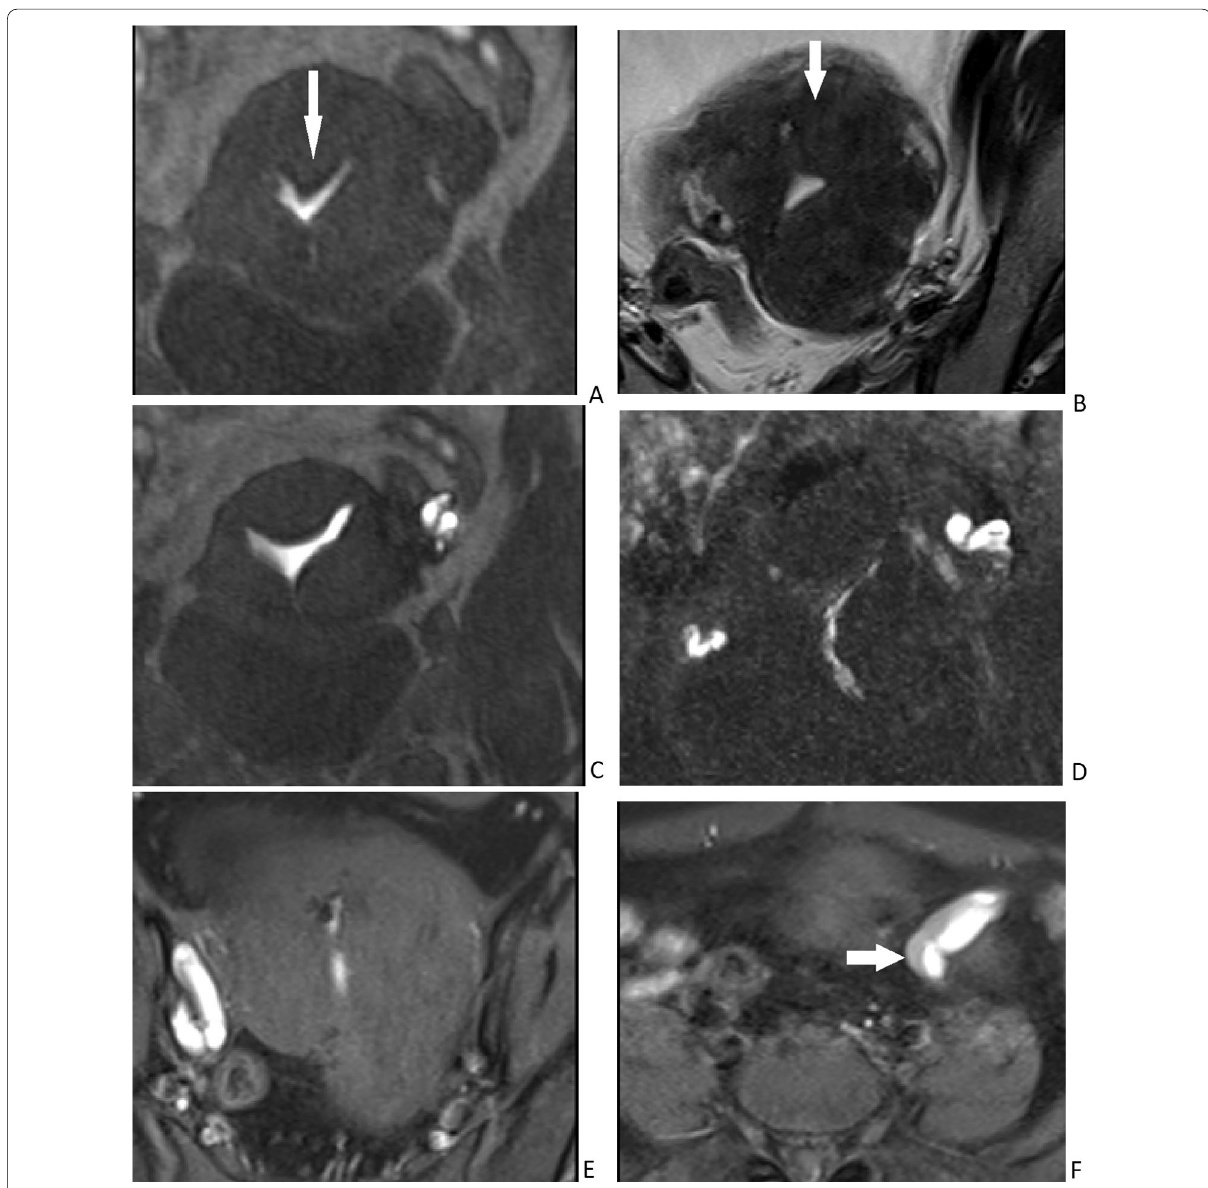
Fig. 5 Thirty-five-year-old female evaluated for primary infertility, A-F subtracted dynamic 3D T1 weighted angiographic (TRICKS) MR HSG image of first injection of dilute gadodiamide showing deformity of endometrial cavity in fundal region ( A ) (arrow), T2W axial image showing multiple fibroids, with one causing (arrow) the deformity in endometrial canal as seen on MR HSG ( B ). Subtracted dynamic 3D T1 weighted angiographic image showing left ( C ) and bilateral hydrosalpinx ( D ). Postcontrast fat sat T1 weighted axial image showing contrast in right ( E ) and left ( F ) fallopian tubes showing fluid level consistent with hematosalpinx (arrow).No spill seen on bilateral